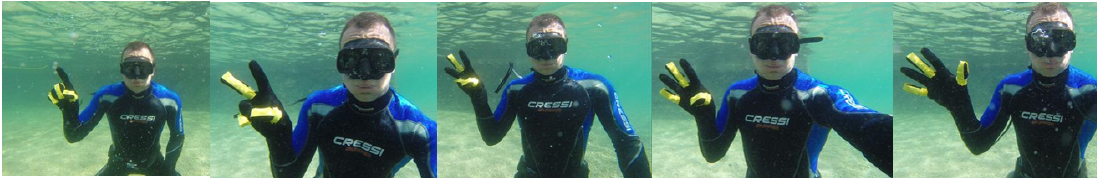
Figure 4. Trials gestures: numbers from 1 to